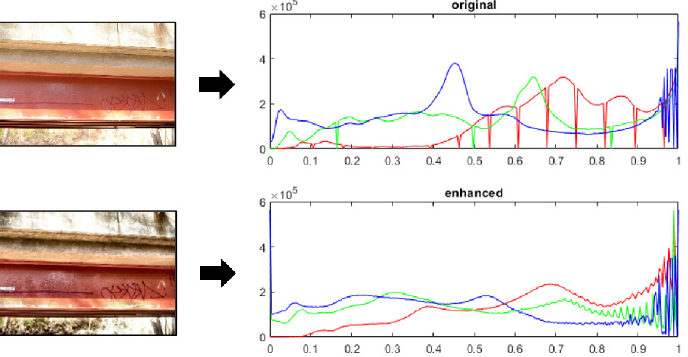
Figure 10. Images before ( top ) and after ( bottom ) image processing using the CLAHE algorithm. The three-chanel histograms are to the